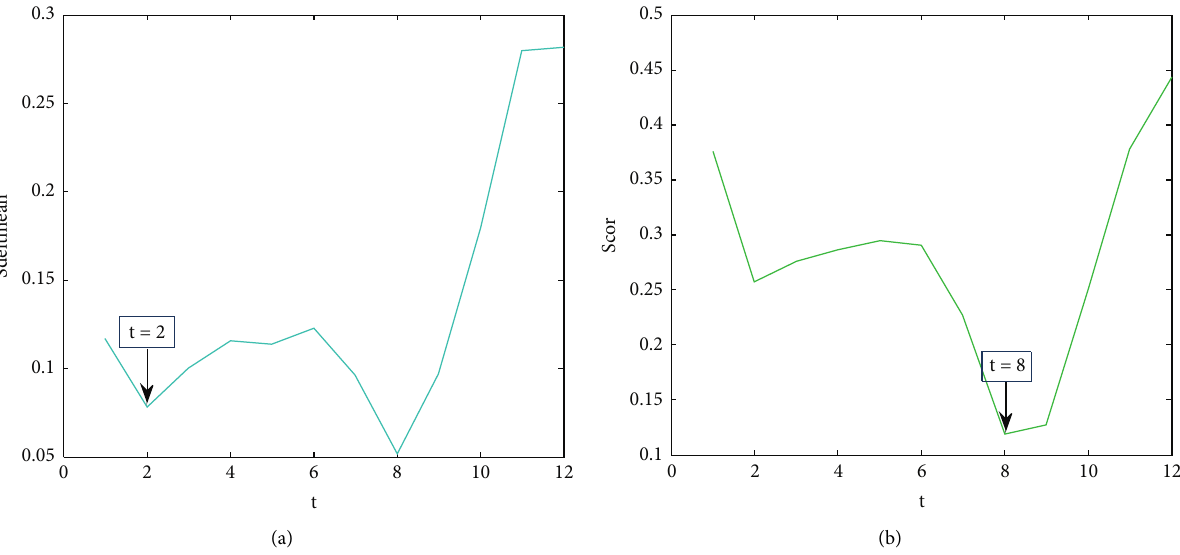
Figure 6: Rumor C-C algorithm results.